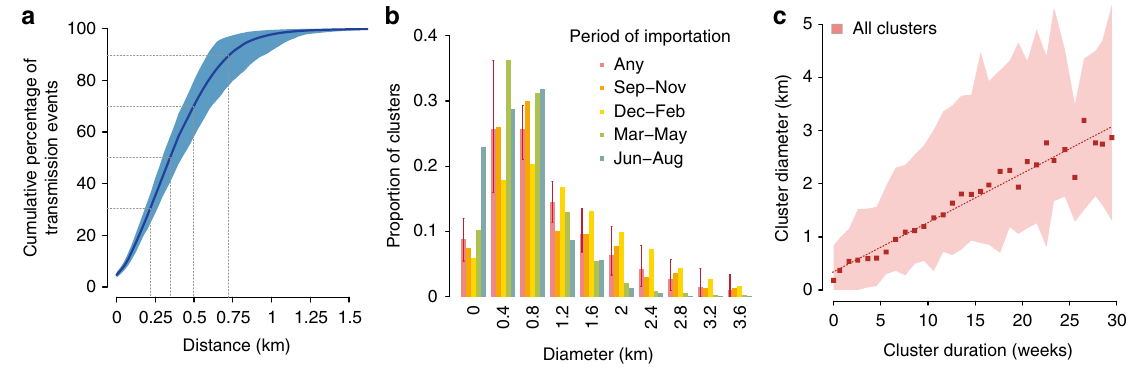
Fig. 4 Focal transmission of dengue. a Estimated cumulative proportion (and 95%CI) of transmission events as a function of distance. Dashed lines highlight transmission distances at 30, 50, 70, and 90-percentiles of transmission events. b Distribution of the cluster diameter (and 95%CI) as resulting from the analysis of all transmission clusters, or by considering clusters seeded in different time periods. c Relation between cluster diameter and duration as resulting from the analysis of all transmission clusters; points: average diameter; shaded area: 95% CI; dashed line: